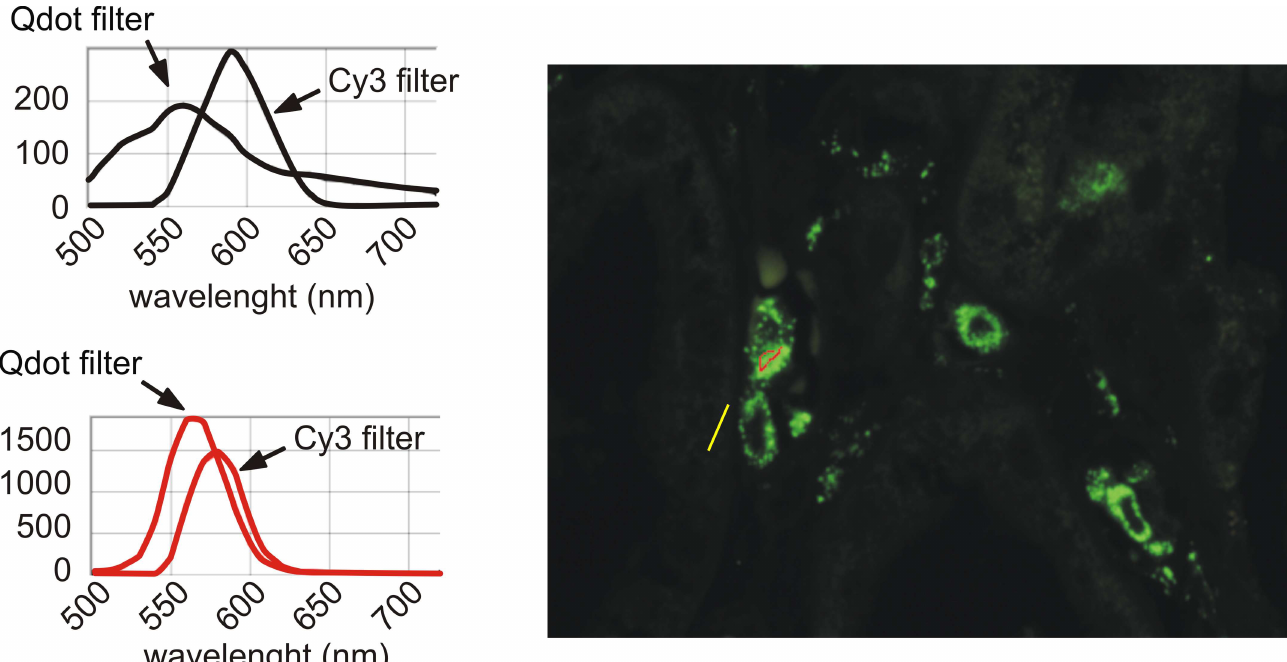
Fig 10. Significantbleed throughof Qdot565 in Cy3 filterwhenilluminatedwithwhitelightLED. A slide stainedwith Qdot565 was imagedwith Nuance throughQdot filterand Cy3 filterusing SOLA white light illumination. The specific and autofluorescence spectra (left panels) are obtainedby samplingthe appropriateimageareas (ie positive cell for specific fluorescence: red line & curves;background for autofluorescence:yellow line & black curves)on the cube of imagescontaining imagesat 10 nm intervalsbetween500 & 720nm thoughboth filtercubes (rightpanel).As expected the spectra throughthe 2 emissionfiltersare different(Cy3 emissionfilter593/40;Qdot emission filter500LP)as the Cy3 filtershould pass wavelengths from567 nm semrock [16],while the Qdotfilteris a long pass filterfrom494nmChroma(see ASCII data in [15])